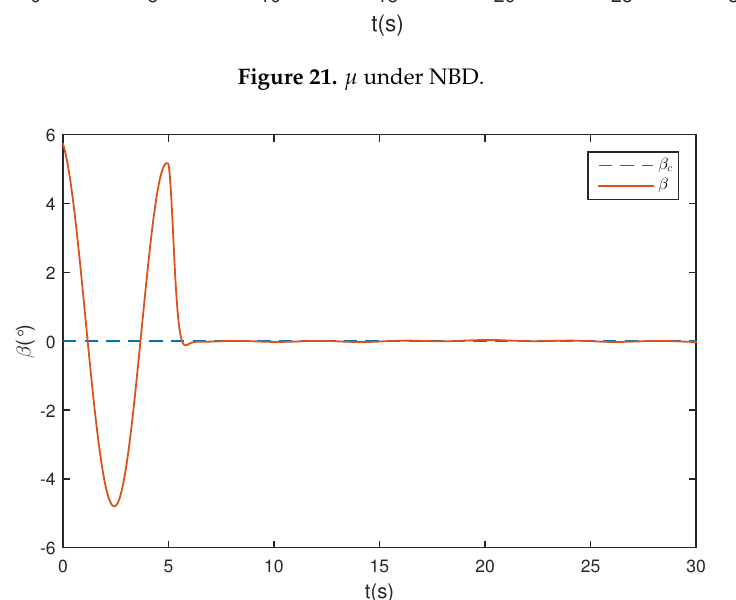
Figure 21. µ under NBD.